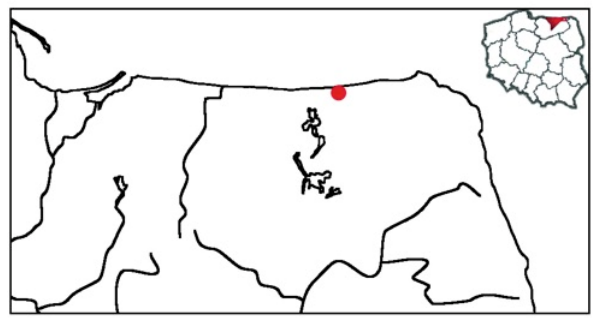
Figure 1. Location of the Pyramid in Rapa, Banie Mazurskie commune (NE